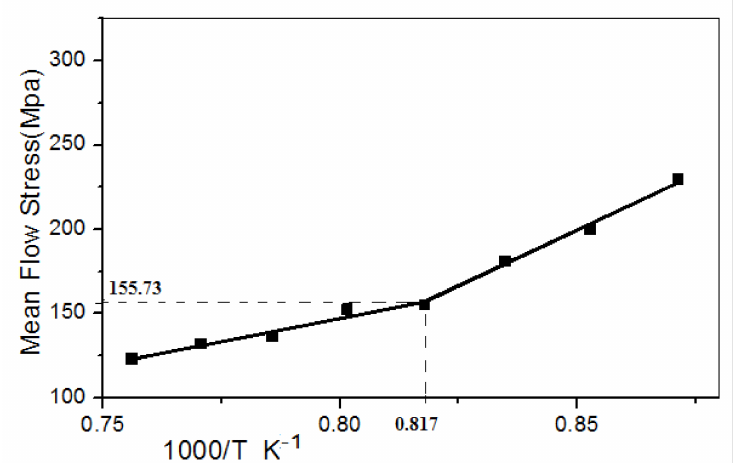
Figure 7. Graph of MFS against the inverse of absolute